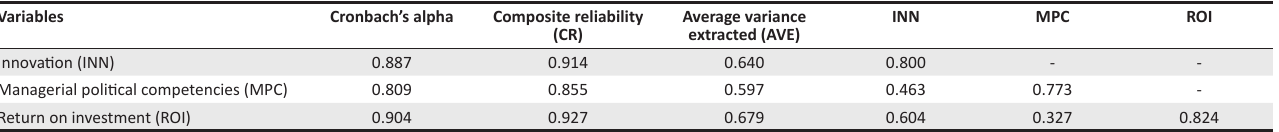
TABLE 1 : Reliability and validity statistics results.